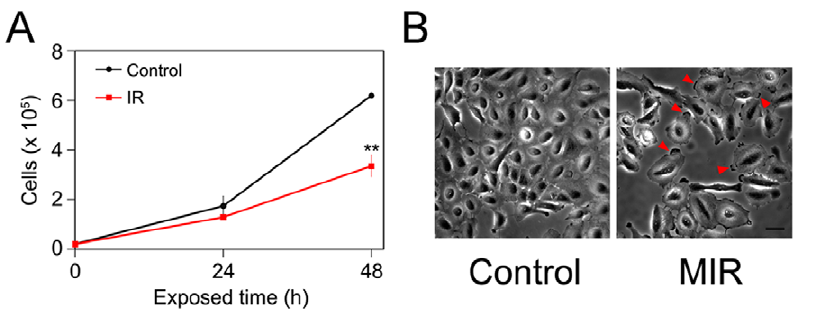
Figure 2. Effects of MIR exposure on cell proliferation and the morphology of A549 cells. (A) The cell numbers were measured at 0, 24 and 48 hours after MIR exposure by using Trypan blue and a hemocytometer. The average cell numbers of control (unexposed) and MIR exposure treatments were expressed as means 6 SD from three independent experiments. ** P , 0.01. (B) Cell images were observed by phase-contrast microscopy after 48 hours MIR exposure. Arrows indicate the radial aprons of enlarged cells. Scale bar represents 50 m m.